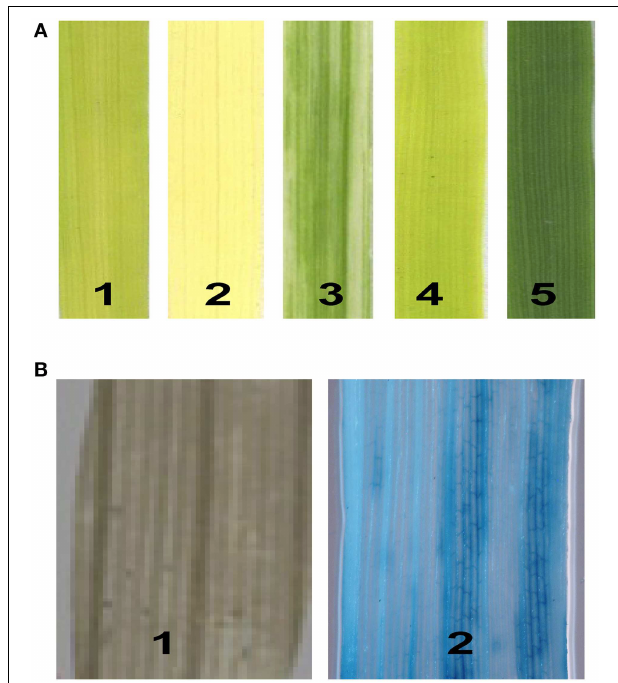
FIGURE 1 | Isolation of chlorophyll-deficient mutants from the T-DNA-mutagenized population. (A) The phenotypes of the chlorophyll-deficient mutants: 1, yellow; 2, albino; 3, stripe; 4, pale green; and 5, wild type. (B) GUS expression patterns in the leaves: 1, negative; 2, vascular